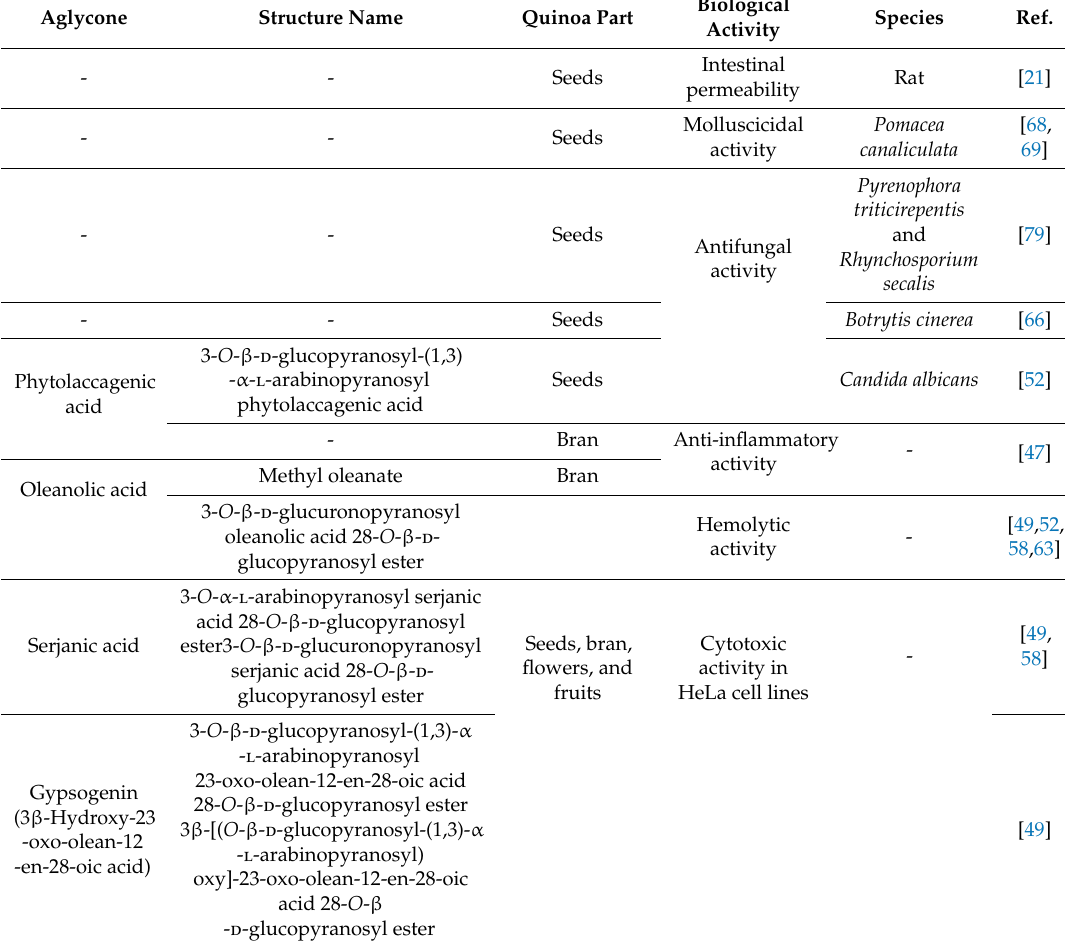
Table 4. Biological activities of quinoa